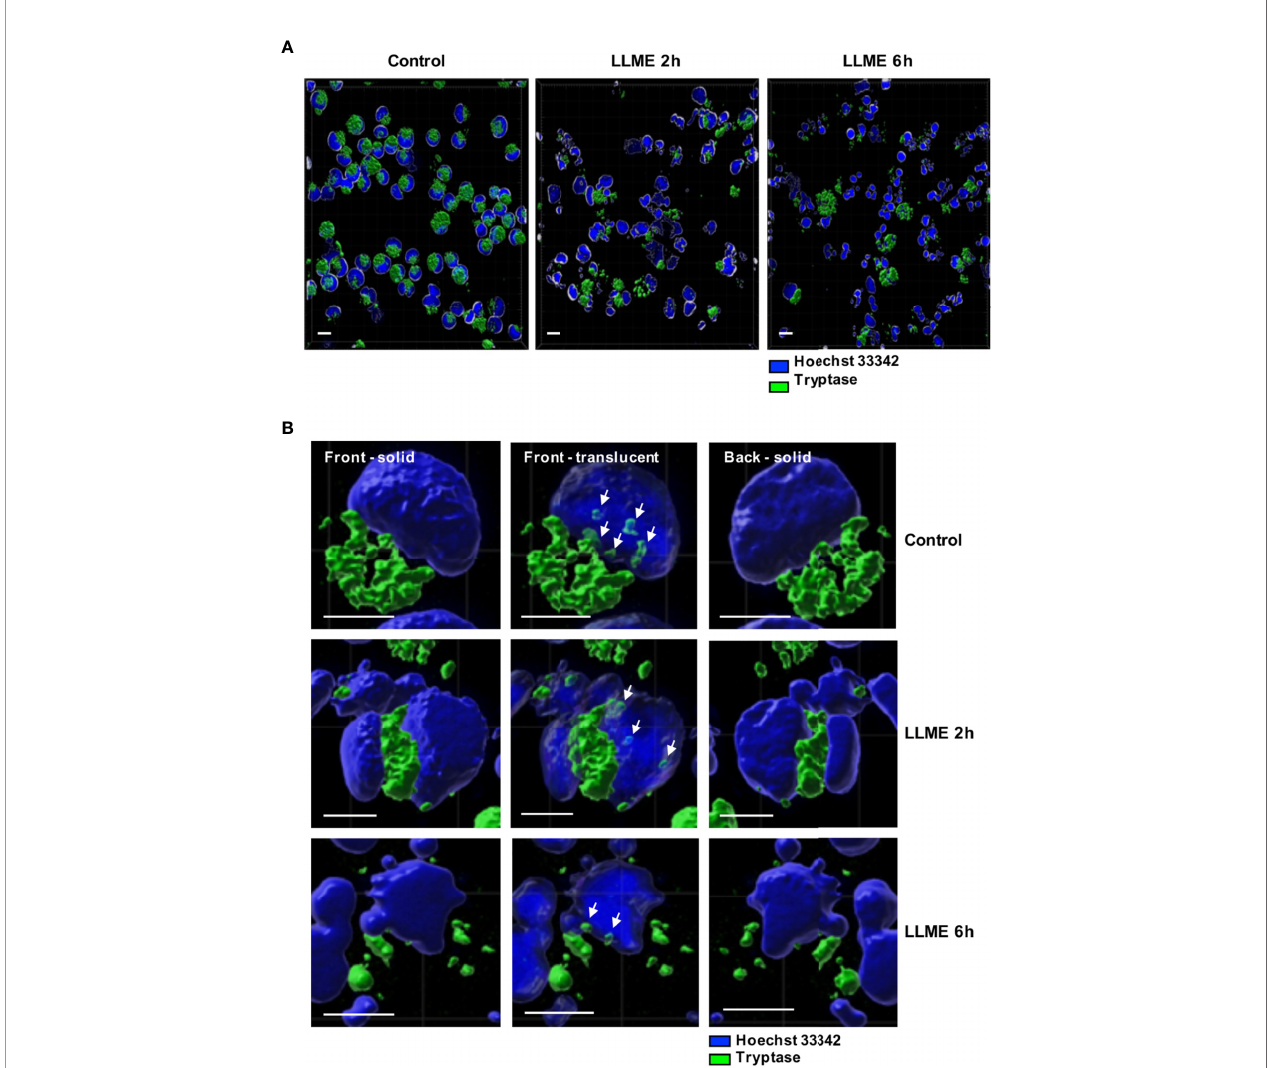
FIGURE 6 | Tryptase is found in the nucleus of HMC-1 cells. HMC-1 cells (0.5 x 10 6 cell/ml) were either left untreated or treated with 400 m M LLME for 2 or 6 hours. Cells were stained for tryptase and nuclear DNA (Hoechst 33342), followed by confocal microscopy analysis. (A) 3-D view generated from Z-stack sections. Note the abundant tryptase staining in the cytoplasm of control cells and a gradual decline in tryptase staining after LLME treatment; bar scale = 10 m m. (B) The left and right panels show solid front and back views of the same control cell or cells treated with LLME for either 2 or 6 hours. The middle panels show translucent nuclear structure. Note that the translucent depiction of nuclei reveals the presence of tryptase within the nuclear compartment of both control- and LLME-treated cells (indicated by white arrows); bar scale = 5 m